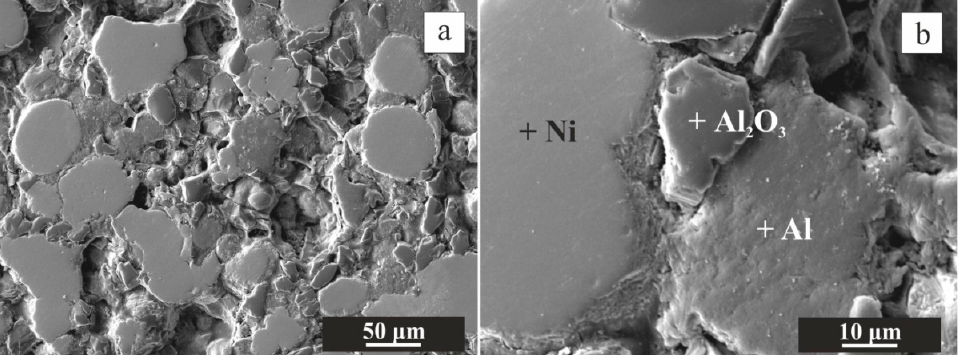
Figure 3. SEM images from the central region of the CIP green tablet at magnification 300× ( a ) and 1500× ( b ). The phases, determined by EDS, are denoted by cross ( b ).